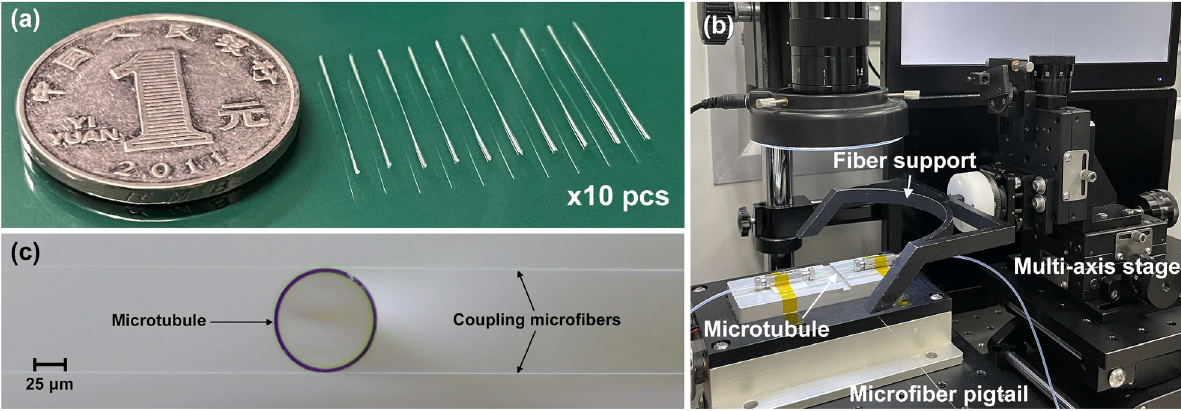
Figure 3: Coupling of disposable microtubule.